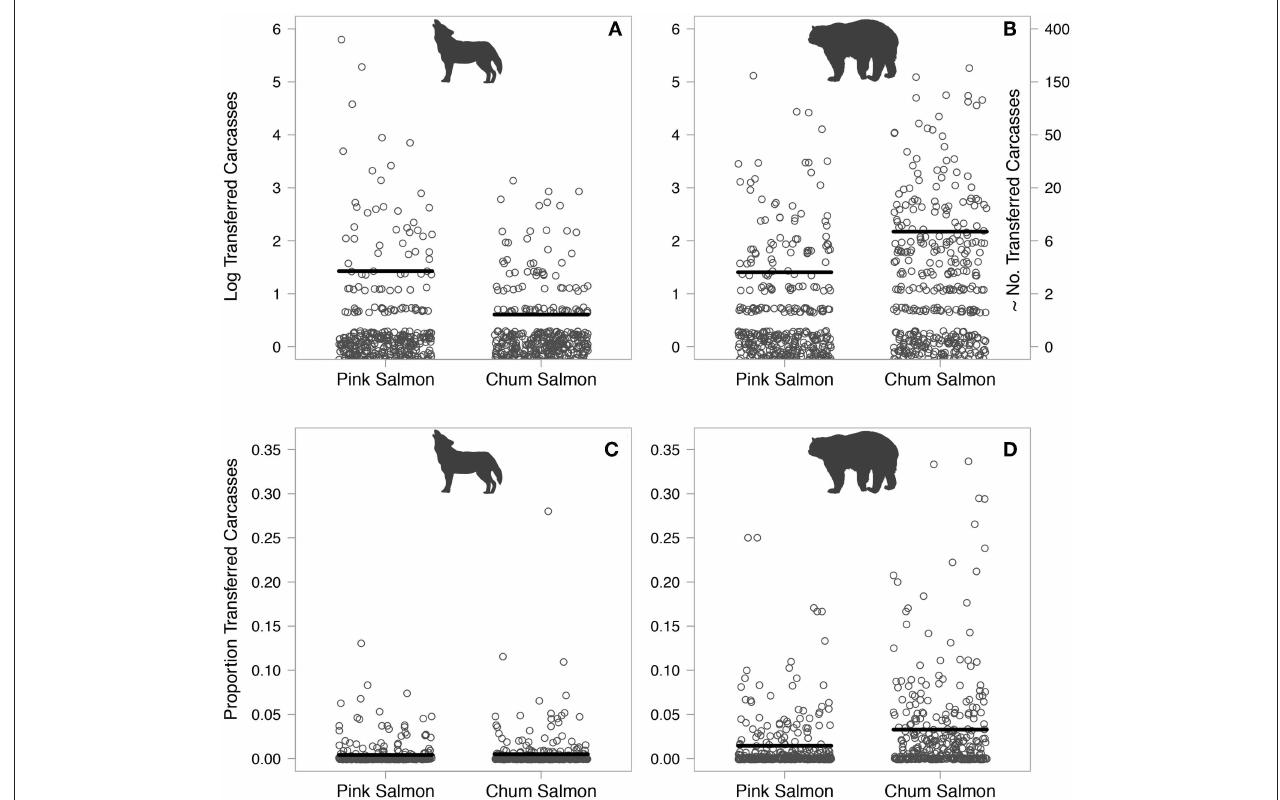
FIGURE 5 | Log-transformed counts of wolf- (A) and bear-transferred (B) carcasses for each salmon species per stream section. Proportion of total salmon consumed by wolves (C) and bears (D) per stream section. Proportions were calculated as the number of wolf- or bear-consumed carcasses relative to total salmon (sum of wolf and bear consumed, senescent and live) per stream section. Horizontal lines indicate mean values. Data points are jittered horizontally for display purposes. Gaps in data are a result of log-transformation.